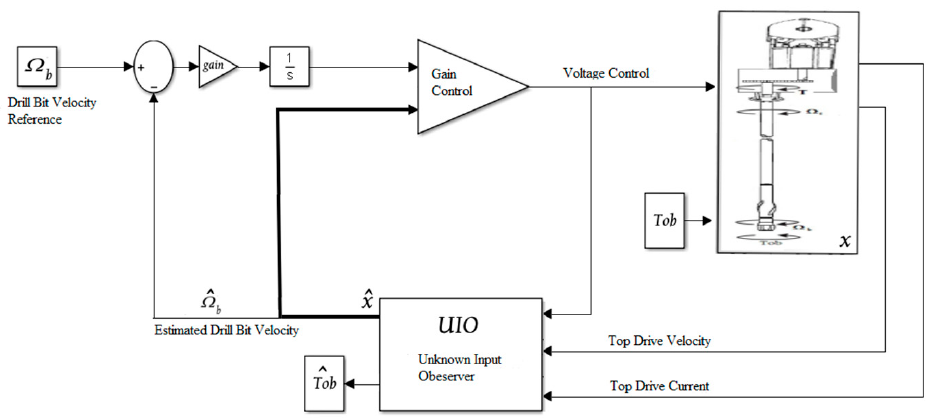
Figure 11. General Scheme of the rotary drilling system with Observer-based H ∞ design.